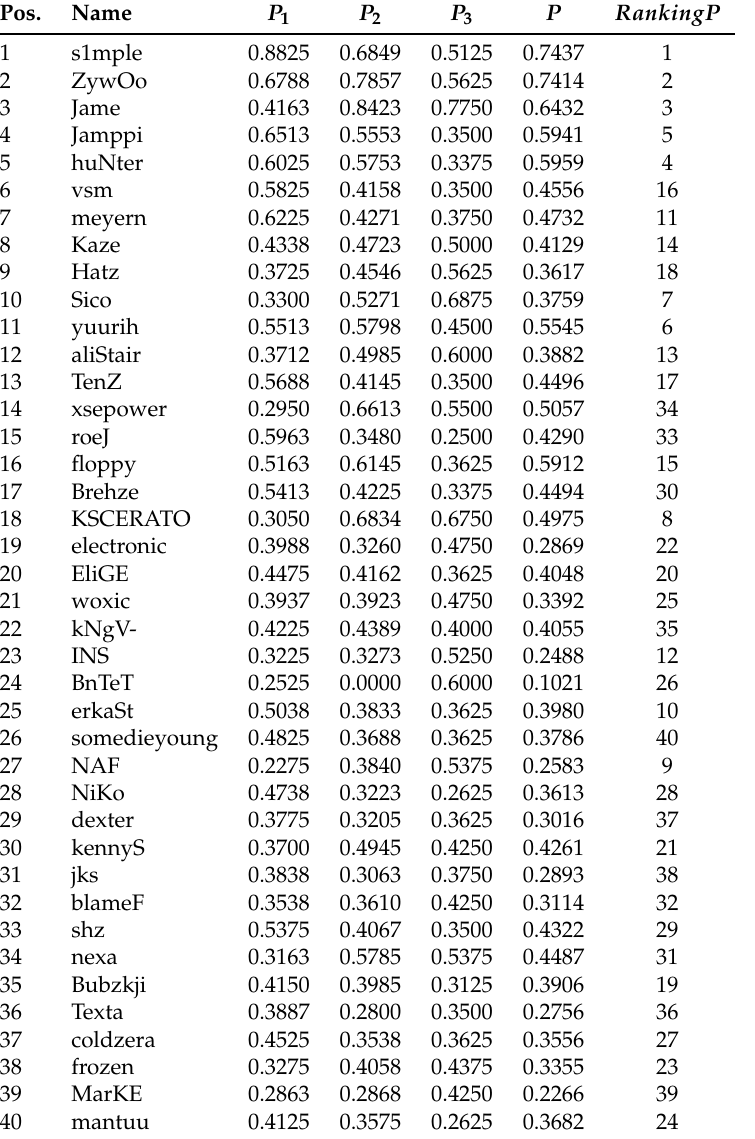
Table 13. The performance table of the related assessment models and final ranking.